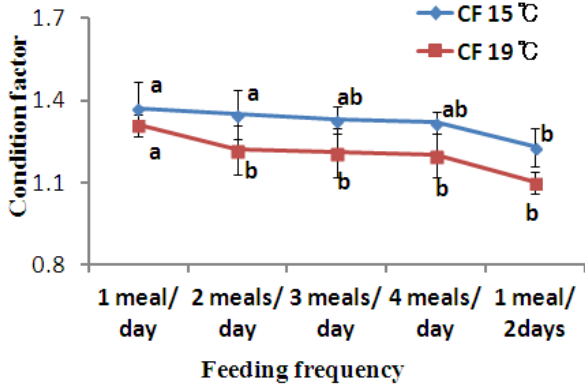
Figure 2. Condition factor of rockfish with different feeding frequencies at 15°C and